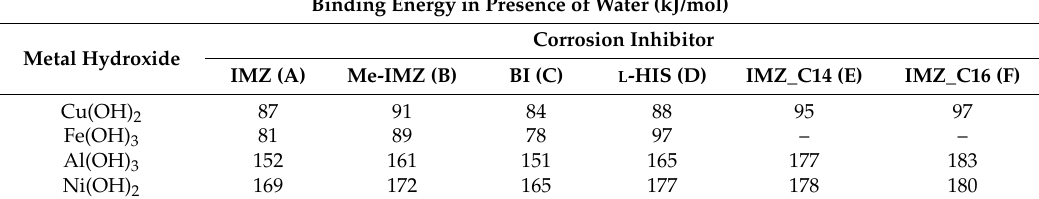
Table 2. Calculated Binding Energy of different corrosion inhibitors onto various metal hydroxide substrates in the presence of